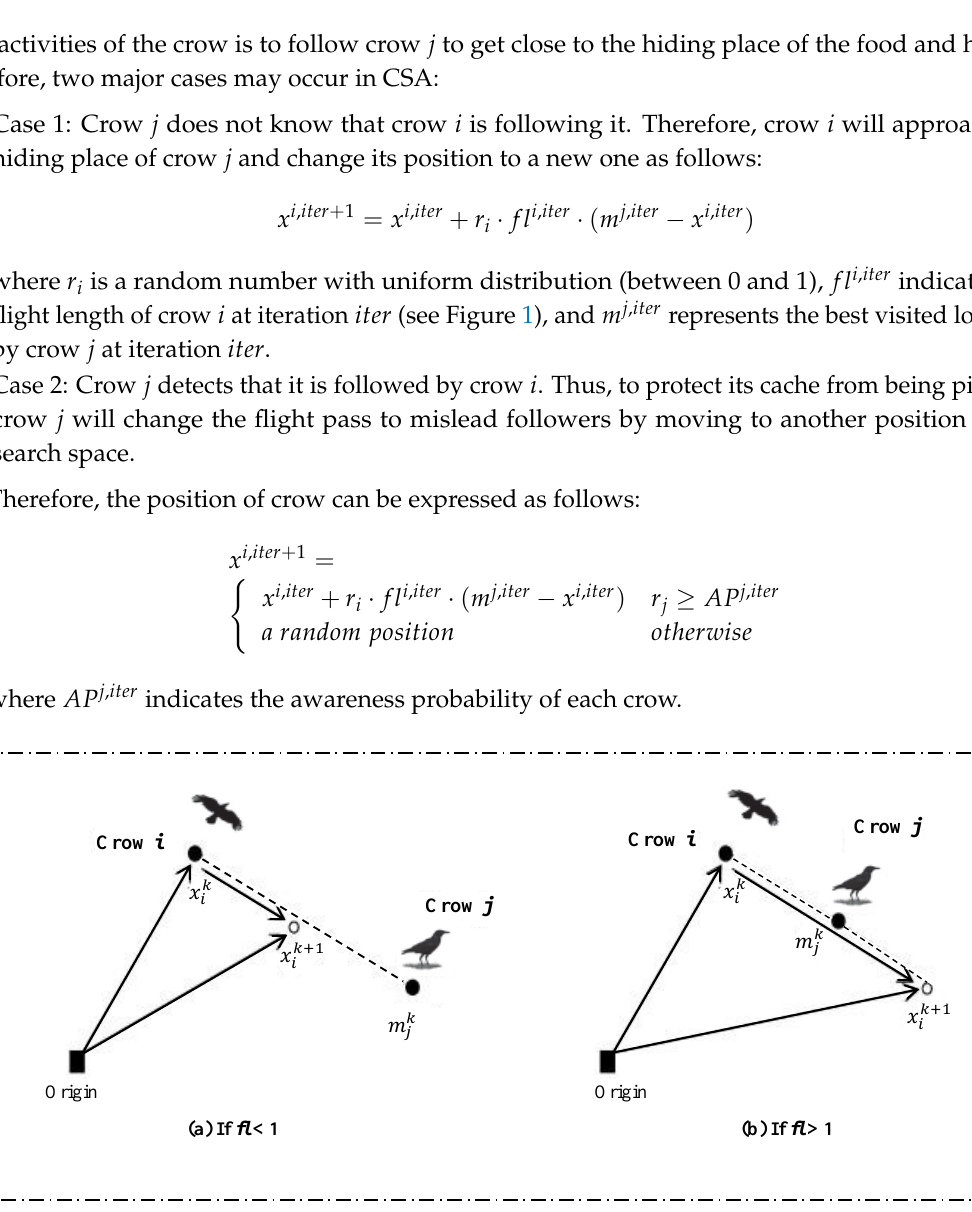
Figure 1. The characteristics of the crow flight length on search